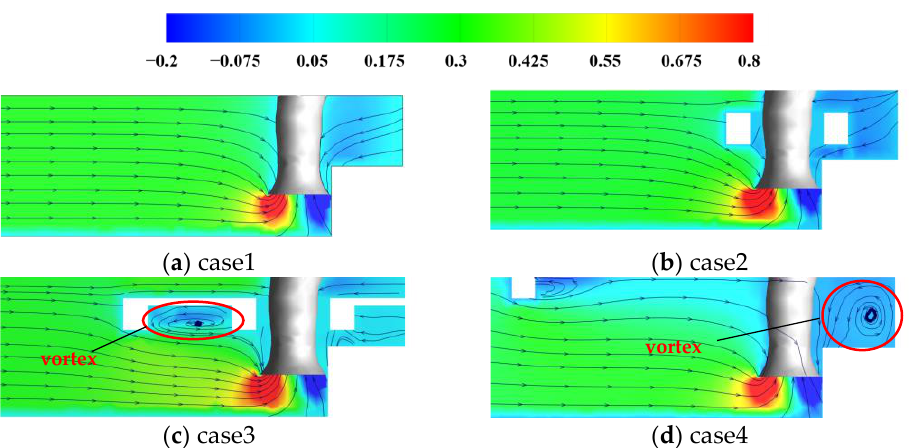
Figure 6. Contour of velocity distribution in longitudinal profile of the sump.